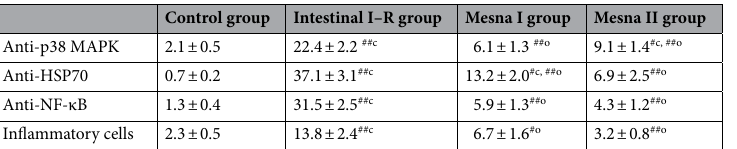
Table 3. Number of anti-p38 MAPK, anti- HSP70 immune-stained cells, anti- NF-κB and the number of inflammatory cells. Values are expressed as mean ± standard error (X ± SE). p38 MAPK p38 mitogen-activated protein kinase, HSP70 heat shock protein 70, NF-κB nuclear factor kappa beta. # Significant difference ( P < 0.05). ## Highly significant difference (P < 0.001); n = 10 animals. c P compared to control group. o P compared to intestinal I–R